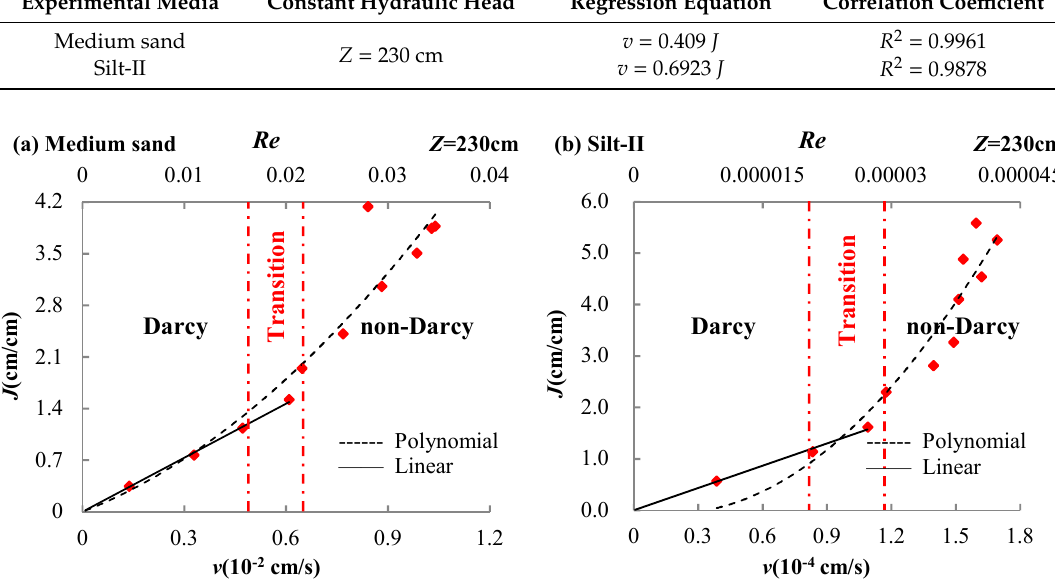
Figure 5. Polynomial (Forchheimer) fitting (in black dotted line) and linear (Darcy) fitting (in black solid line) of the initial data for ( a ) medium sand and ( b ) silt-II under the constant hydraulic head of 230 cm. Note that the red dotted lines represent the transition from Darcy flow to non-Darcy flow.